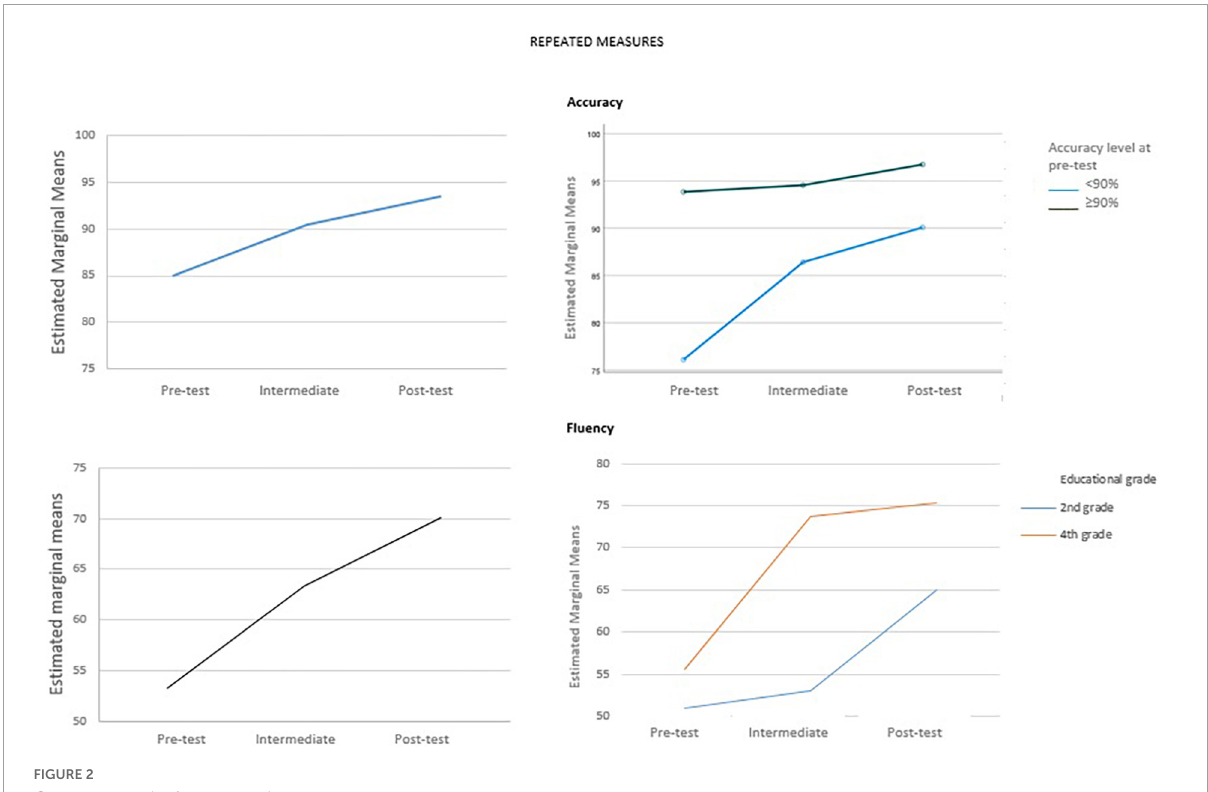
FIGURE2 Contrasts graphs for repeated